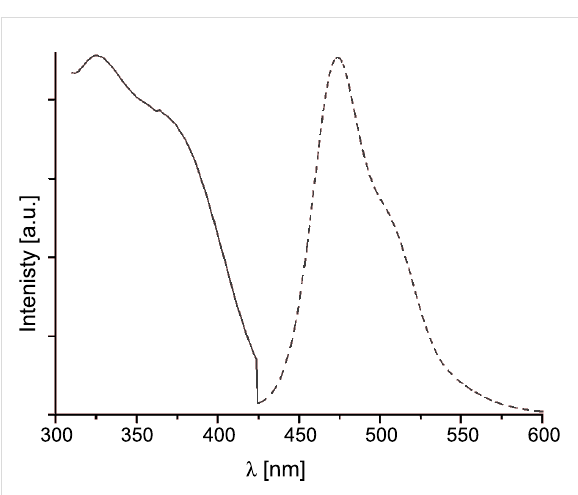
Figure 1: Normalized absorption (solid line) and emission (dashed line) spectra of thioacetate 2d (recorded in dichloromethane, T = 298 K).